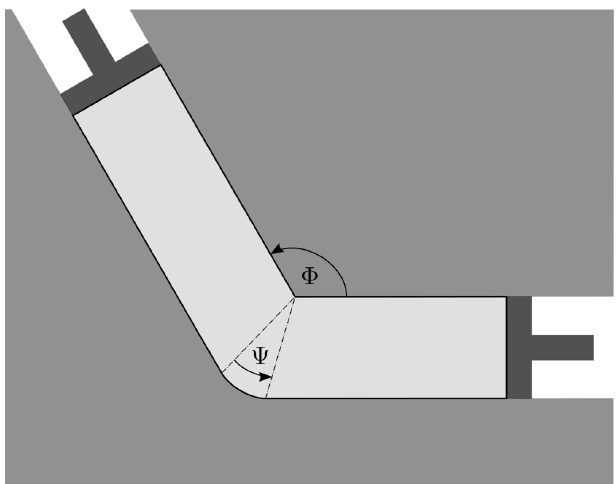
Figure 1. Sketch of an Equal-Channel Angular Pressing (ECAP) channel with the channel angle Φ and the angle Ψ defining the outer